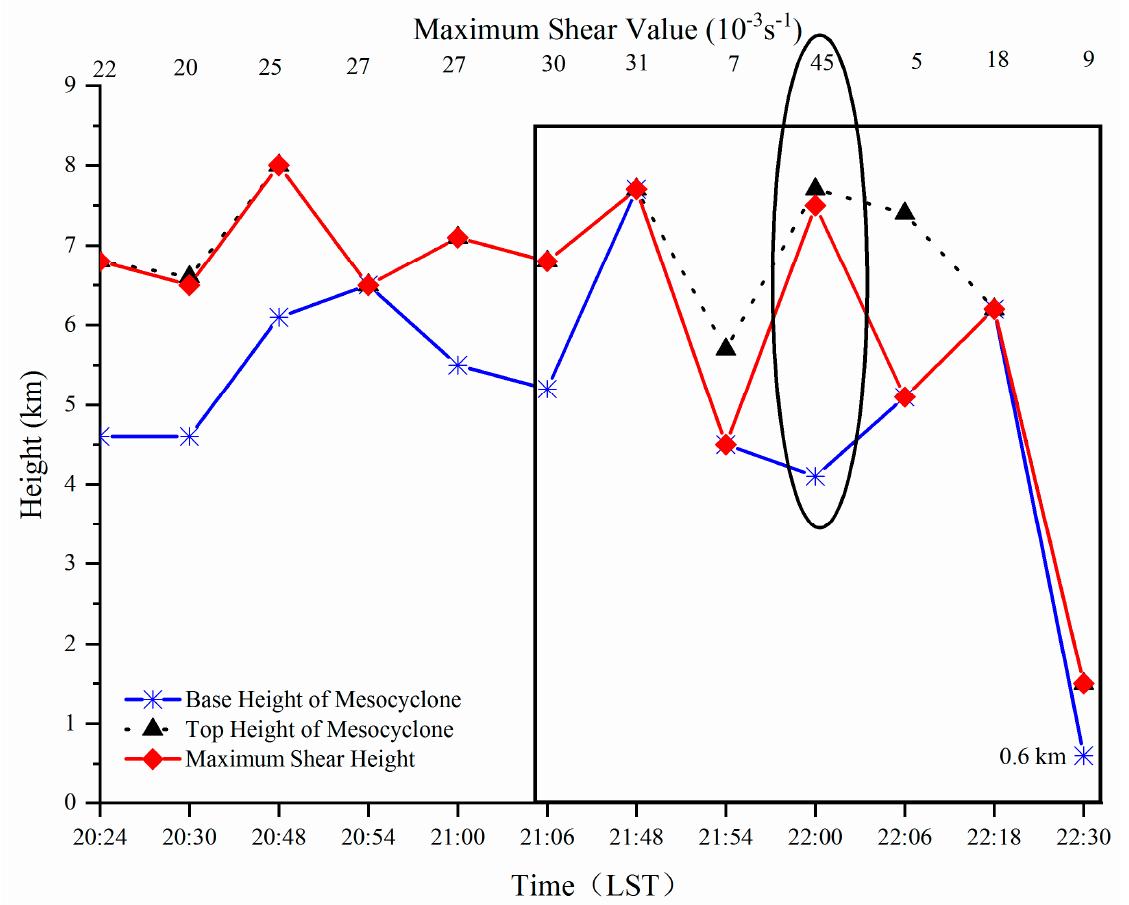
Figure 6. Time evolution of top, bottom, and strongest shear heights of the mesocyclone in this hailstorm supercell, marked with black dashes, solid blue and solid red lines, respectively. The numbers at the top of the graph are the strongest shear values.